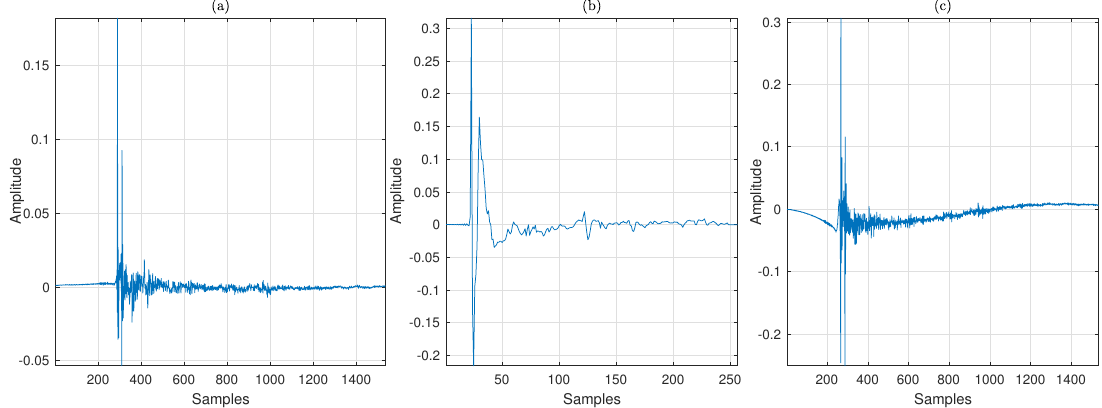
Figure 7. Primary and secondary paths. ( a ) Primary path. ( b ) Secondary path. ( c ) Least square solution of the control filer.